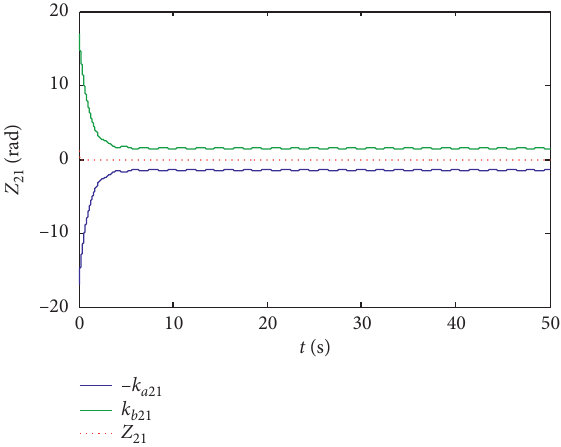
Figure 22: Constraint effect of Z